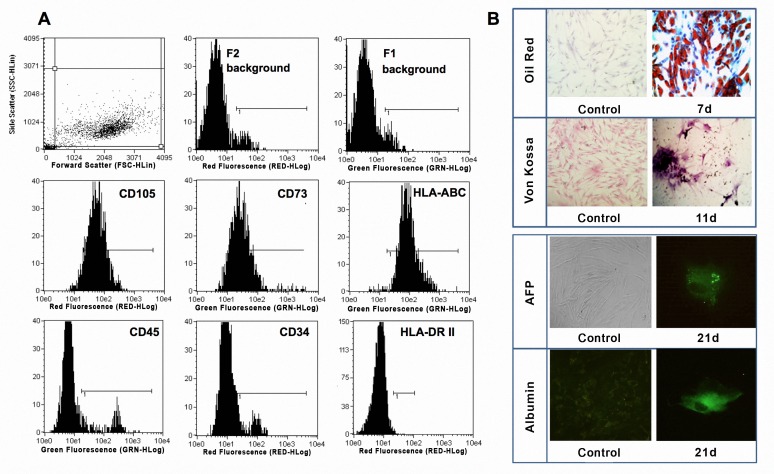
Characterization of hADSCs.(A) Phenotypic characterization of ADSCs showed cell markers CD105, CD73 and HLA-ABC positive in the population. CD45, CD34 and HLA-DR resulted negative in selected population. (B)Functional characterization of ADSCs into adipogenic, ostegenic and hepatic linage. Photographs (40X) showed non-differentiated cells (control) used as controls of staining and IF and cells positive for lipid droplets (oil red), extracellular calcium deposition (Von Kossa) and IF for AFP and Albumin (FITC).